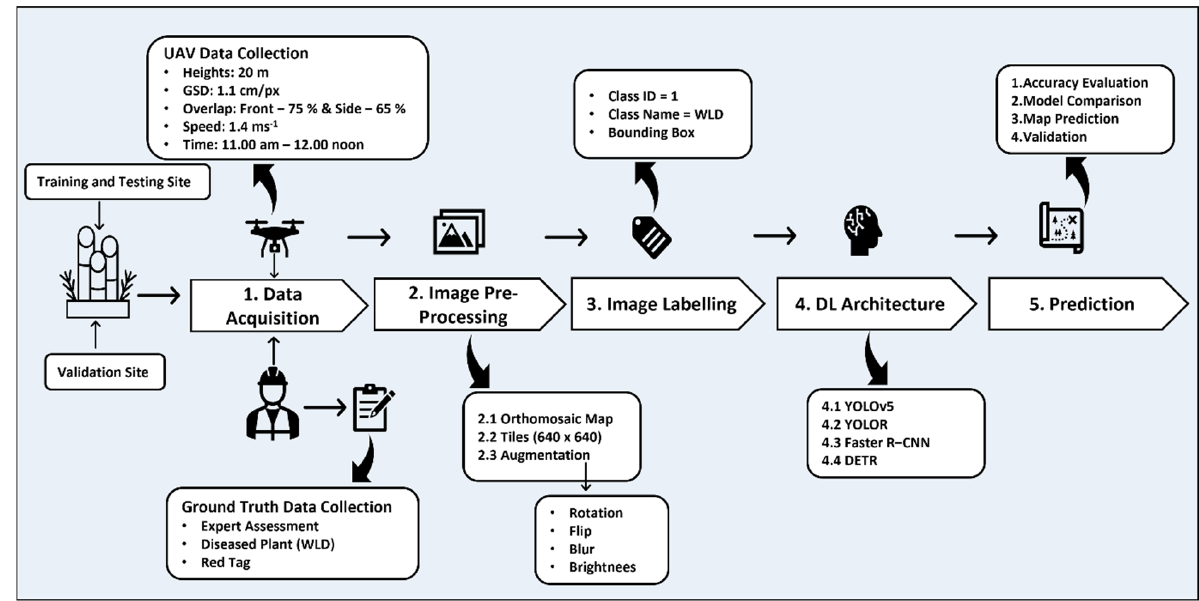
Figure 1. Core steps of the proposed methodology to detect WLD using unmanned aerial vehicles.